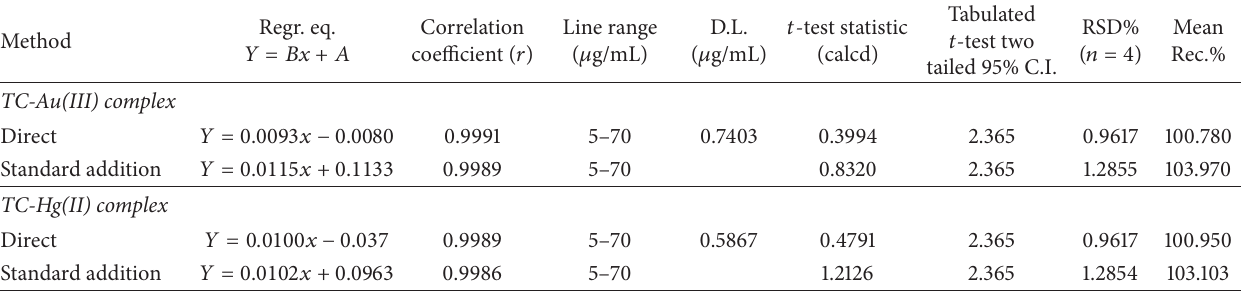
Table 3: Regression equation, correlation coefficient, 𝑡 -test concentration ranges, detection limits, and RSD% direct and standard addition calibration curves of TC-Au complex by using uv-visible